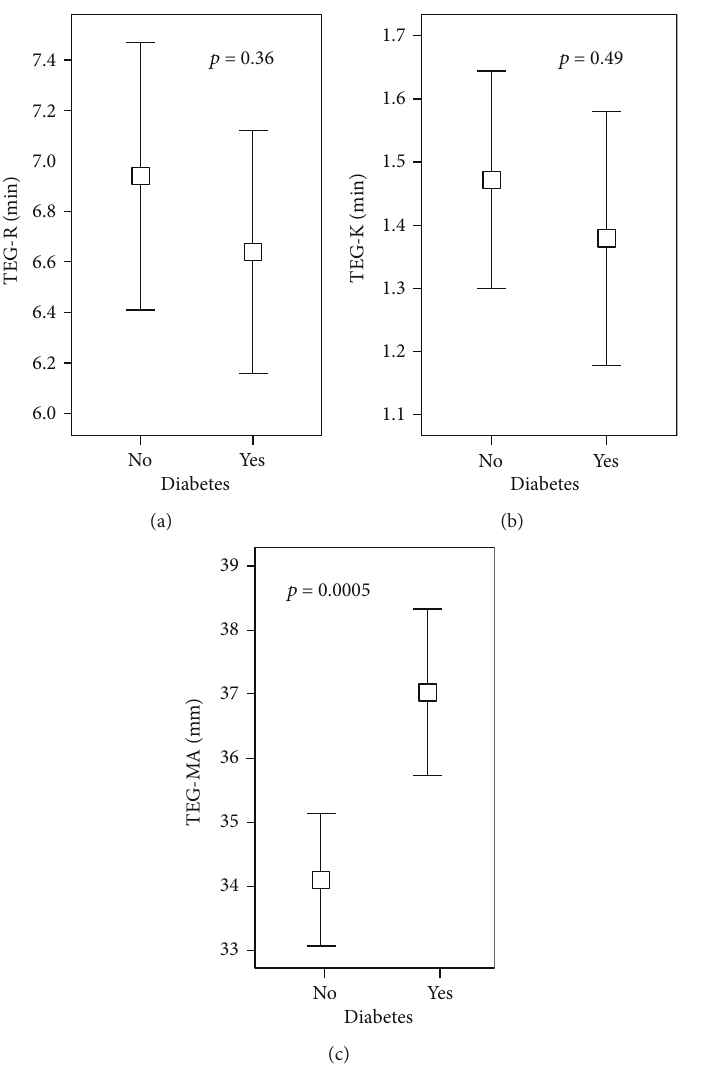
Figure 1: Thrombelastography measures between subjects with diabetes mellitus and without diabetes mellitus in platelet-poor plasma. (a) TEG-R: time to fi brin formation. (b) TEG-K: clot formation time. (c) TEG-MA: maximal fi brin clot strength. Mean ± 95% con fi dence interval.